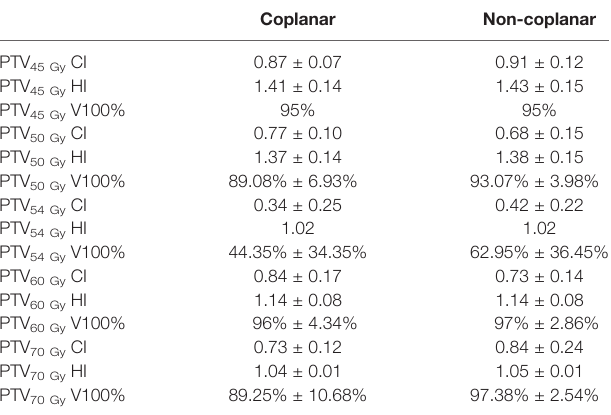
TABLE 2 | Dosimetric parameters of targets for coVMAT and ncVMAT plans. Coplanar